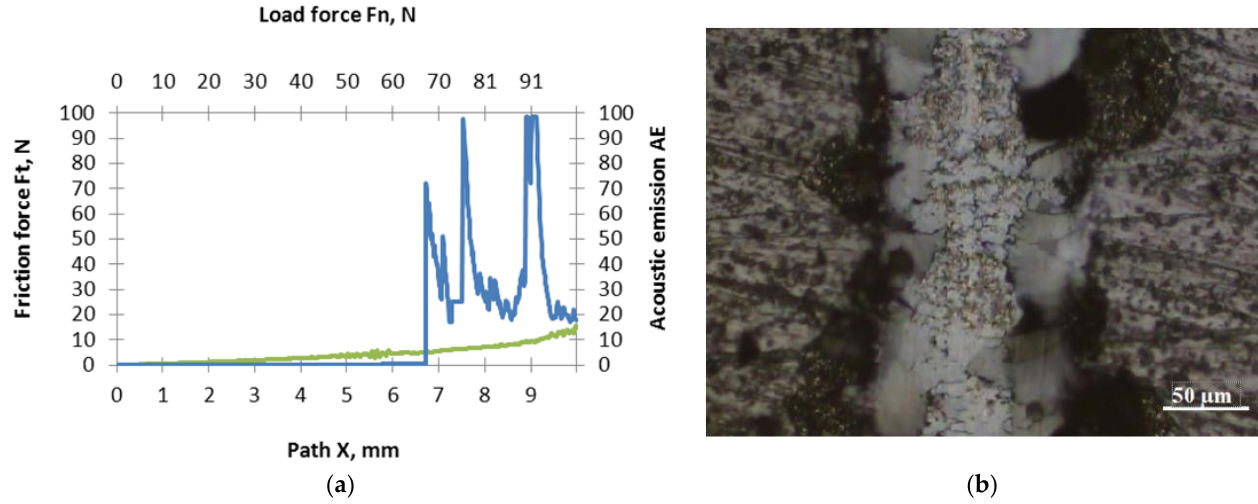
Figure 3. Scratch test results of the (Ti,Al)N coating surface deposited on Al 2 O 3 + TiC oxide ceramics substrate ( a ) diagram of the dependence of the acoustic emission (AE) seen as blue line and friction force Ft seen as green line, ( b ) characteristic damages.